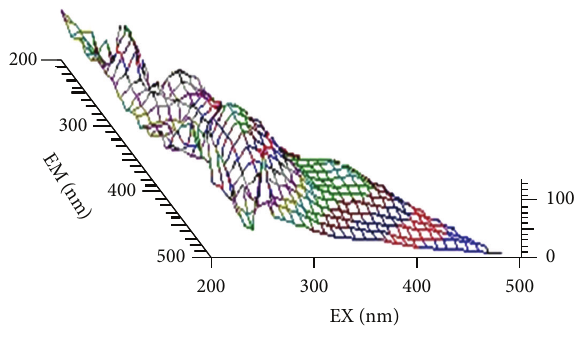
Figure 6: 3D fluorescence spectra of